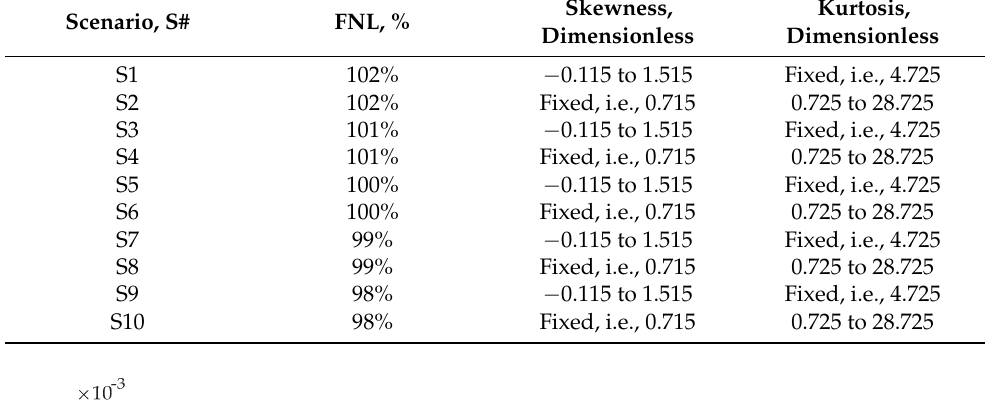
Table 4. Scenario for three parameters: FNL, skewness ( P sk ), kurtosis ( P k ).